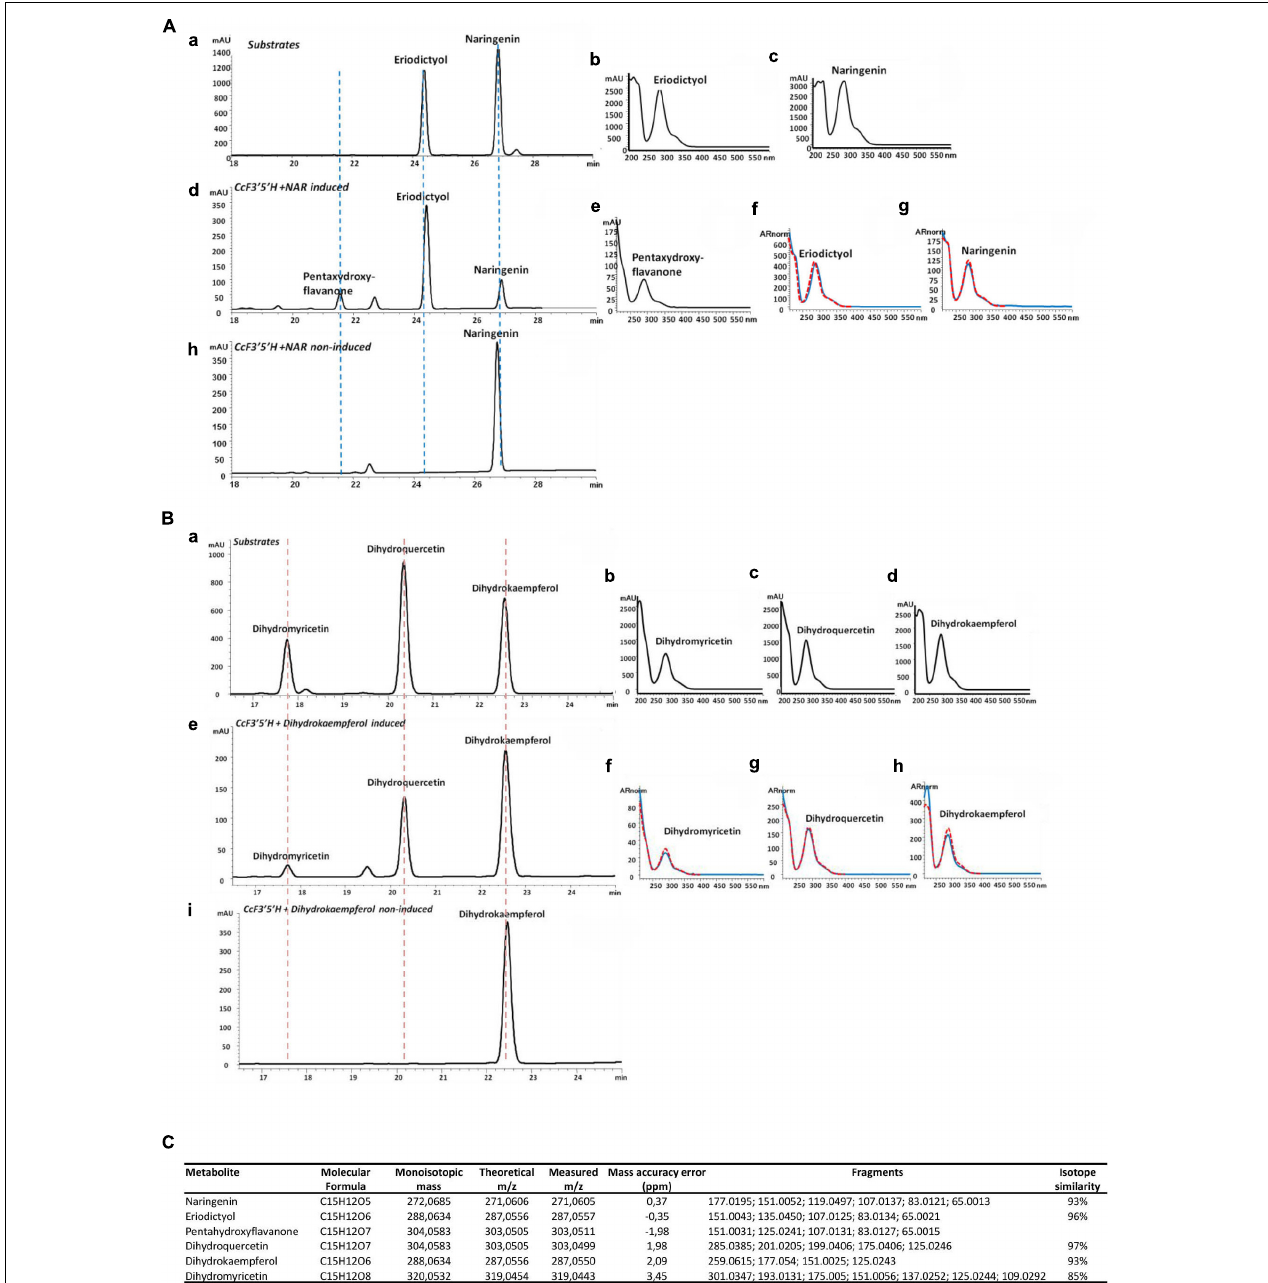
FIGURE 9 | Functional characterization of Cistus creticus F3 (cid:48) 5 (cid:48) H gene. (A) Detection of products in methanolic extracts of yeast culture feeding assay with naringenin after biotransformation with F3 (cid:48) 5 (cid:48) H gene. Ultra-performance liquid chromatography (UPLC)–photodiode array (PDA) chromatograms of (a) the substrate naringenin and the product eriodictyol and their corresponding absorption (b) and (c); (d) yeast culture transformed with CcF3 (cid:48) 5 (cid:48) H flavonoid hydroxylase after 72 h of feeding with 5 µ M naringenin and the alignment of the identified absorption of the products pentahydroxyflavanone (e) and eriodictyol (f) and the substrate naringenin (g) (line in blue) with the external standards from the diode array detector (DAD) library (line in red); (h) negative control yeast culture transformed with CcF3 (cid:48) 5 (cid:48) H after 72 h of feeding with 5 µ M naringenin without induction with galactose. (B) Detection of products in methanolic extracts of yeast culture feeding assay with dihydrokaempferol after biotransformation with F3 (cid:48) 5 (cid:48) H gene. UPLC–PDA chromatograms of (a) the substrate dihydrokaempferol and the products dihydroquercetin and dihydromyricetin and their corresponding absorption (b), (c), and (d); (e) yeast culture transformed with CcF3 (cid:48) 5 (cid:48) H flavonoid hydroxylase after 72 h of feeding with 5 µ M dihydrokaempferol and the alignment of the identified absorption of the products dihydroquercetin and dihydromyricetin and the substrate dihydrokaempferol (h) (line in blue) with the external standards dihydroquercetin, dihydromyricetin, and dihydrokaempferol from the DAD library (line in red); (i) negative control yeast culture transformed with CcF3 (cid:48) 5 (cid:48) H after 72 h of feeding with 5 µ M dihydrokaempferol without induction with galactose. (C) Table presenting the relevant data of HDMS QTOF MS identification of all six metabolites.